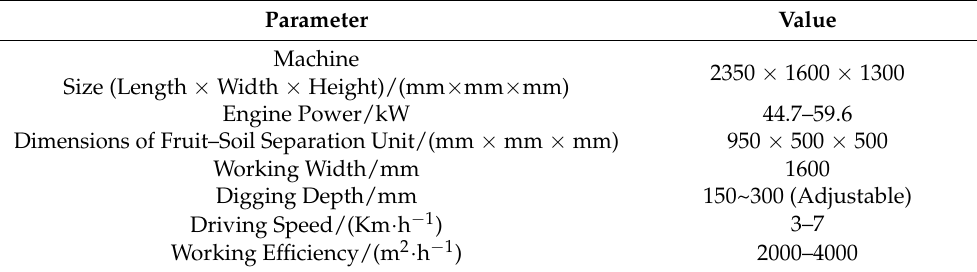
Table 1. The whole structure and key component parameters of the lily